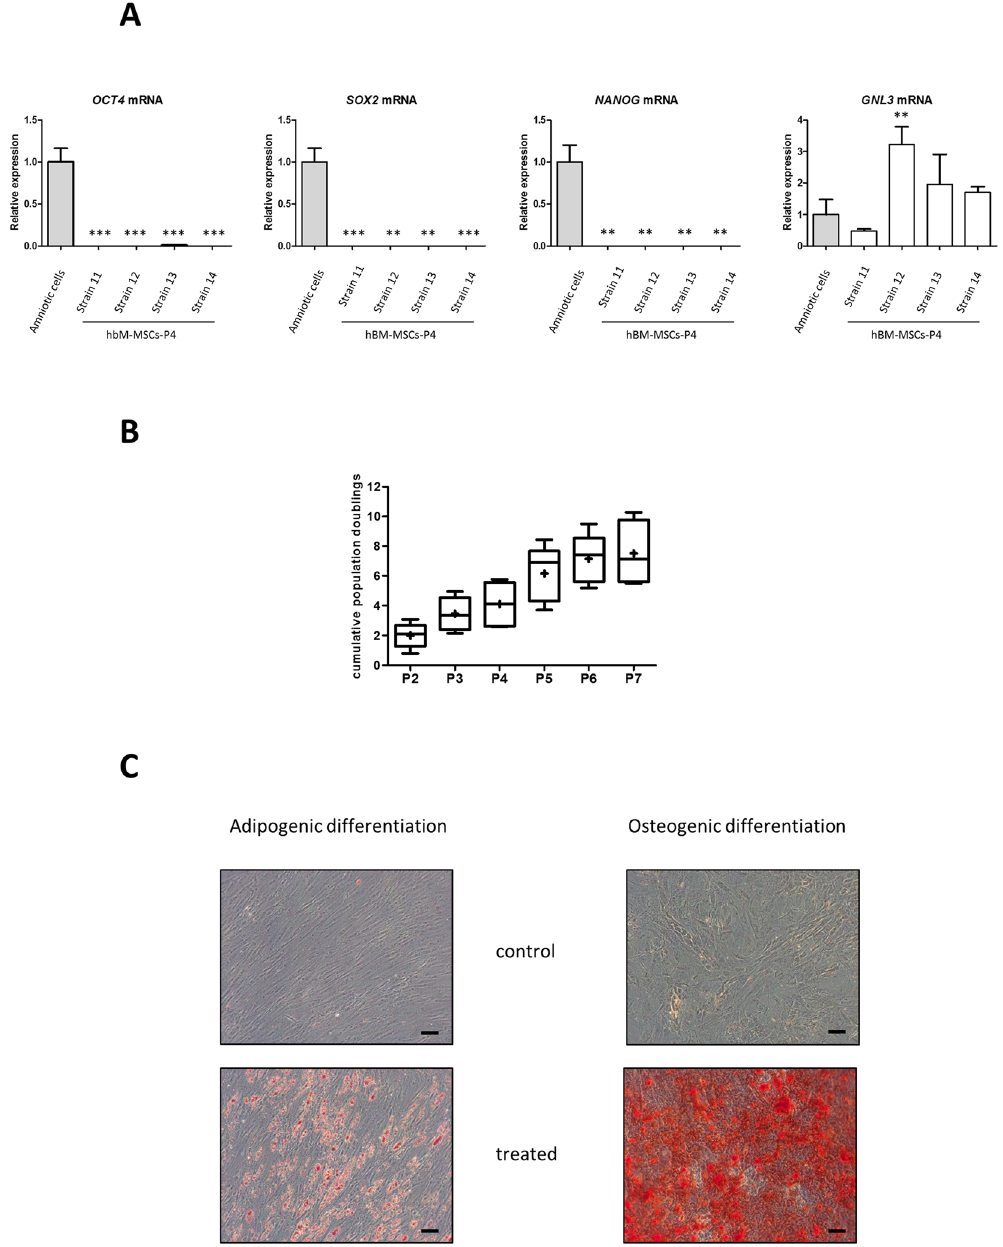
Figure 2. Characterization of hBM-MSCs. A . Analysis of pluripotent stem cell markers in hBM-MSCs. The levels of mRNA encoding Oct4 ( OCT4 mRNA), Sox2 ( SOX2 mRNA), Nanog ( NANOG mRNA), and nucleostemin ( GNL3 mRNA) were measured using real time RT-PCR with specific primers. The results of one experiment performed in triplicate were normalized to RPL13a mRNA levels and are presented as the expression of each gene relative to that of amniotic cells (n = 1). Statistically significant differences between amniotic cells and each MSC strain were determined using the Student’s t -test *** P < 0.001 and ** P < 0.01. B . The proliferation of hBM-MSCs was estimated by determining the cumulative population doublings levels (CPD). The CPD of adherent hBM-MSCs were determined between passages 2 and 7 for five donors (strains 5-9) and are represented as box plots (n = 5). C . Osteogenic and adipogenic differentiation of P5 hBM-MSCs. Left panels show oil red O staining of hBM-MSCs grown in adipogenic conditions (treated) or not (control) (scale bar: 100 µ m). Right panels show alizarin red staining of P5 hBM-MSCs grown in osteoinductive conditions (treated) or not (control) (scale bar: 100 µ m). Images shown are representative of three experiments with different